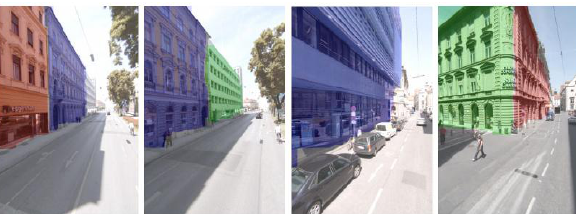
Figure 1: Four examples of automatically segmented street side images into individual building facades. Use is being made of overlapping street-side images. In this example, the camera is pointed forward (from Recky M. et al.,